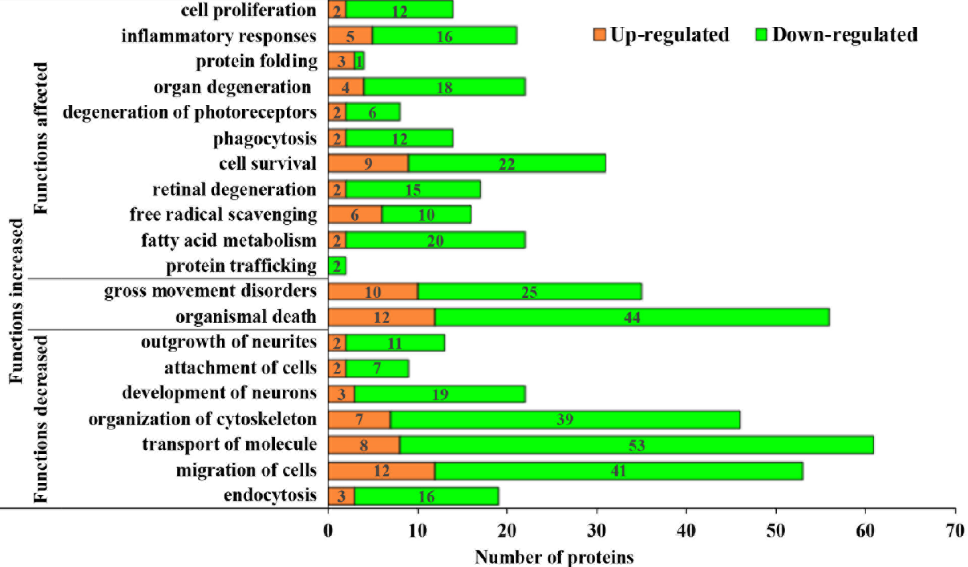
Figure 4. Bar graph of affected pathophysiologic processes that contribute to DR in the MAM of Type 1 diabetic rat retinas. MAM proteins are classified as up- or down-regulated as well as catego- rized into 20 biological processes that are labeled as functionally increased, decreased, or generally affected. DR: diabetic retinopathy, MAM: Mitochondria-associated ER membrane.